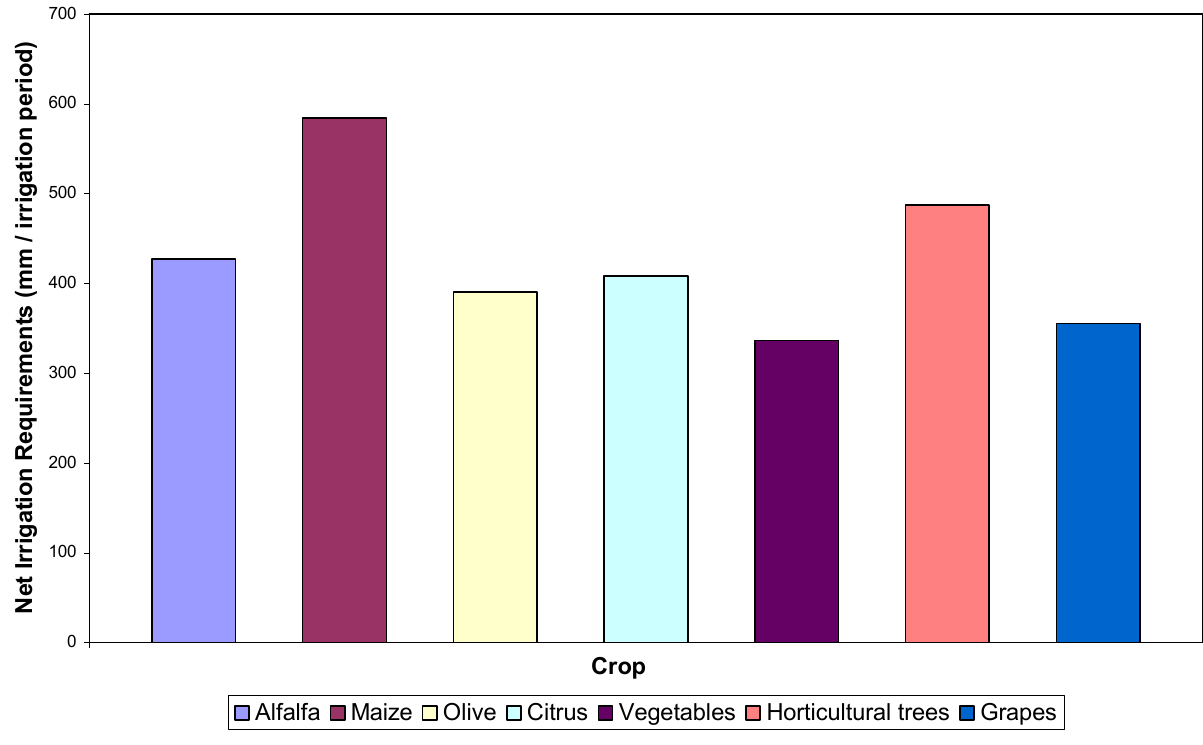
Figure 3. Net Irrigation Requirements for crops in Nafpaktos area.